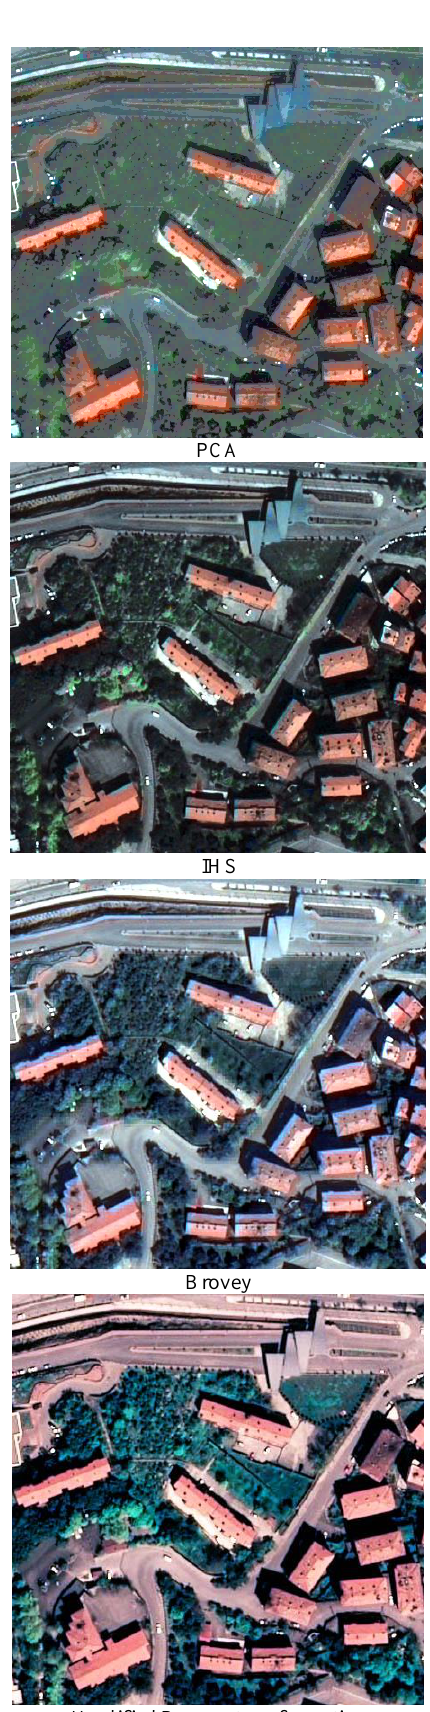
Figure 8. Generated pansharpened images for sample